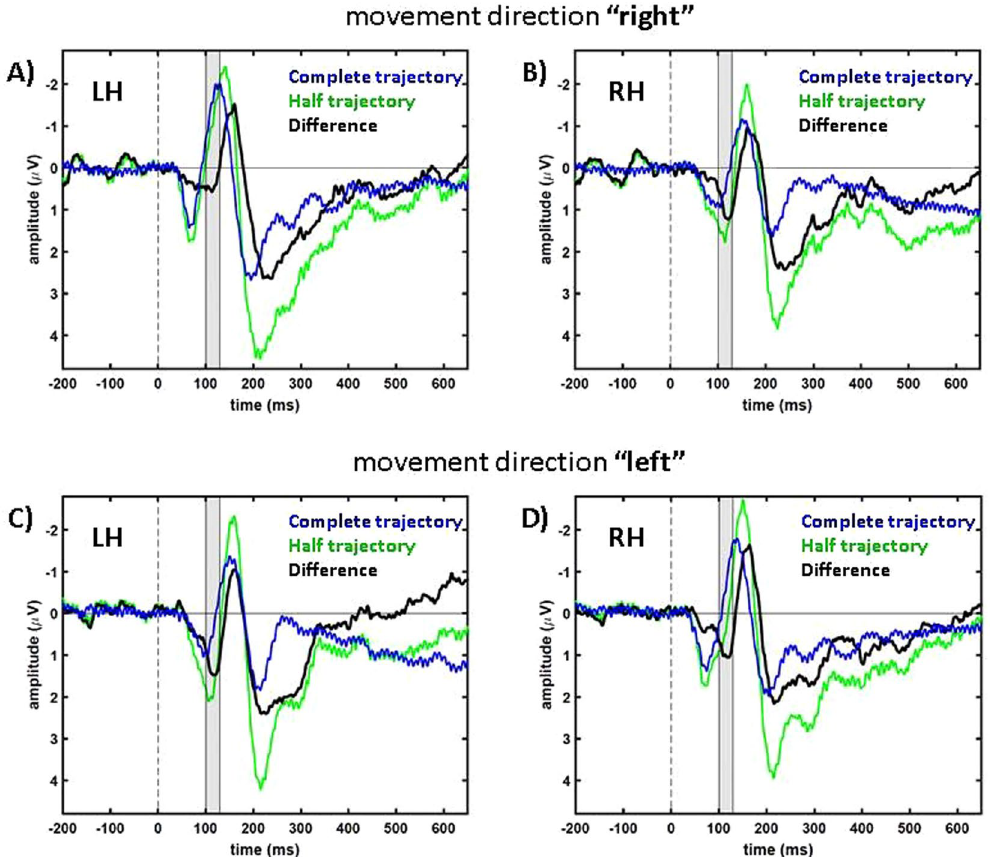
Figure 5. Signals with respect to the motion directions of posterior electrodes in condition “central”. In blue data of the second motion phase of “complete trajectory” trials are presented, in green data of “half trajectory, appear” trials and in black the differences (“complete trajectory”, 2. Phase of standard trials subtracted from “half trajectory, appear” data) are shown. ( A , B ) show condition “right” and ( C , D ) condition “left”. In ( A , C ) data from LH is presented, in ( B , D ) data from RH. The gray area marks the times that were analyzed for this electrode cluster, i.e. 100 ms to 130 ms.